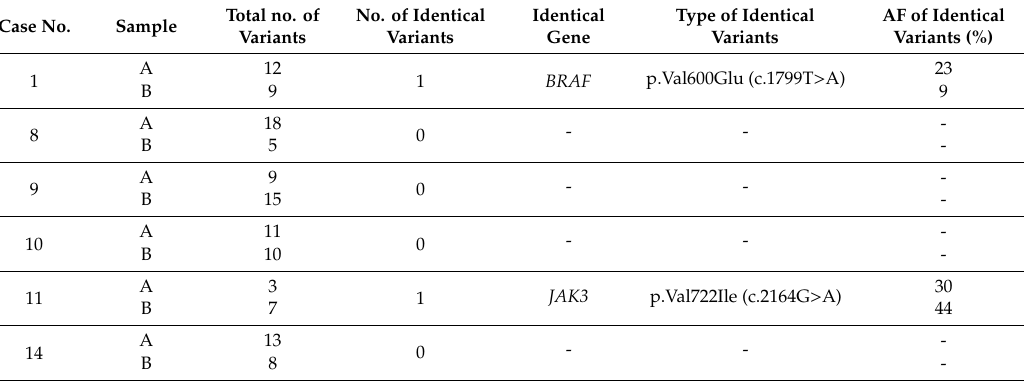
Table 2. Number of gene alterations detected and details of the identical variants in the matched TC determined by a 67 multigene NGS panel. Samples A and B refer to tumors presented in Table 1. (AF: allele